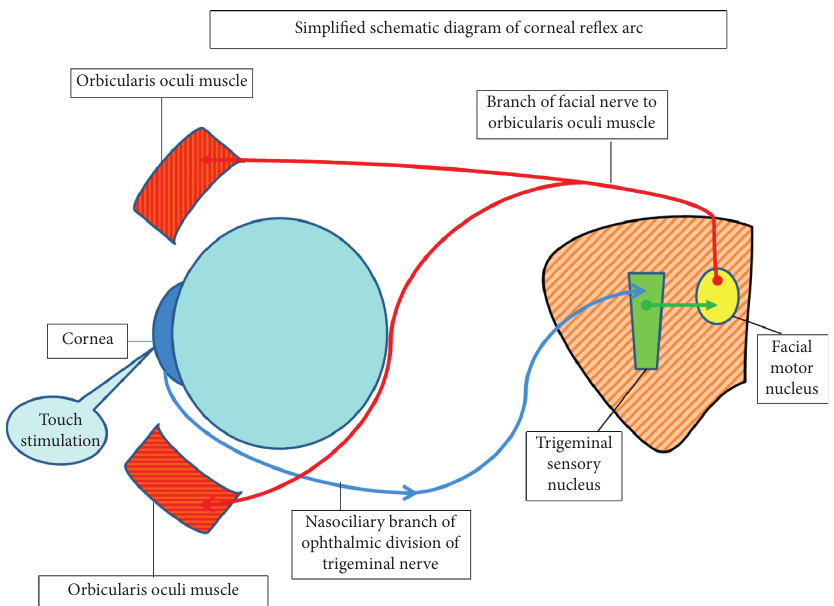
Figure 1: Simplified schematic diagram of corneal reflex